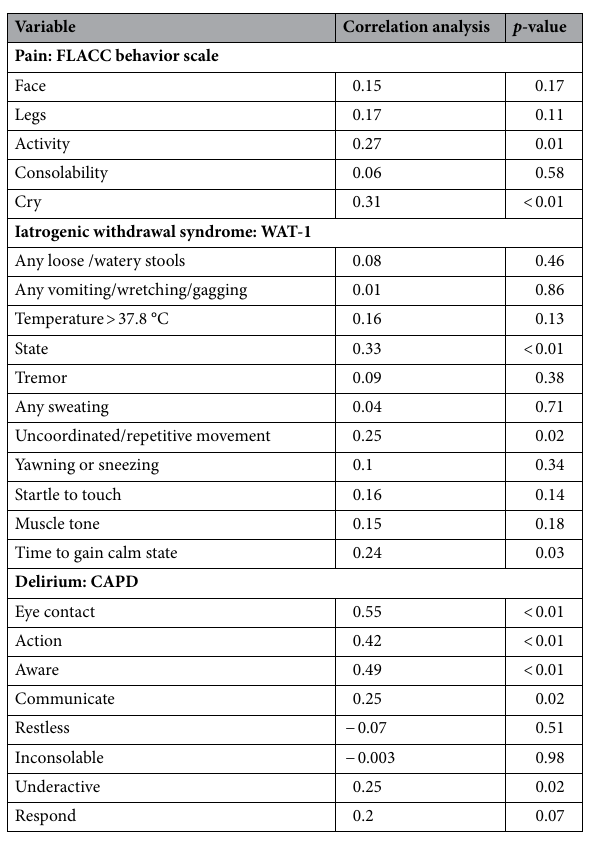
Table 4. Correlation between NSE and pain, delirium, and withdrawal symptoms. CAPD Cornell Assessment of Pediatric Delirium, FLACC Face, Leg, Activity, Consolability behavioral scale, WAT‑1 Withdrawal assessment